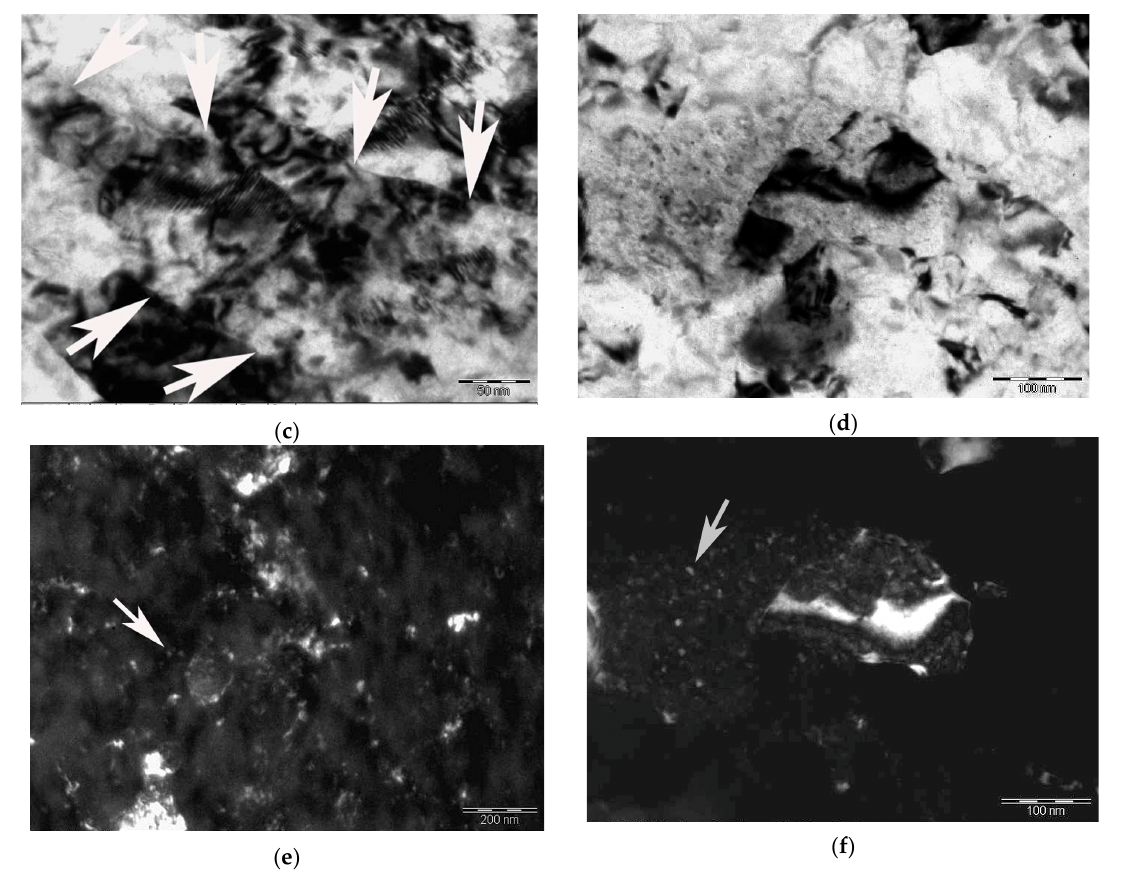
Figure 2. Bright-field TEM images of Grade 91 microstructure: ( a , c ) after tempering at 500 and HPT at 20 °С, where the arrows show the initial boundaries of martensite laths; ( b , d ) after tempering at 800 and HPT at 20 °С; dark-field TEM images of the Grade 91 microstructure; ( e ) TEM after T500 + HPT300 where the arrows show carbides M 23 C 6 ; ( f ) after T800 + HPT200 where the arrows show MX carbonitrides.